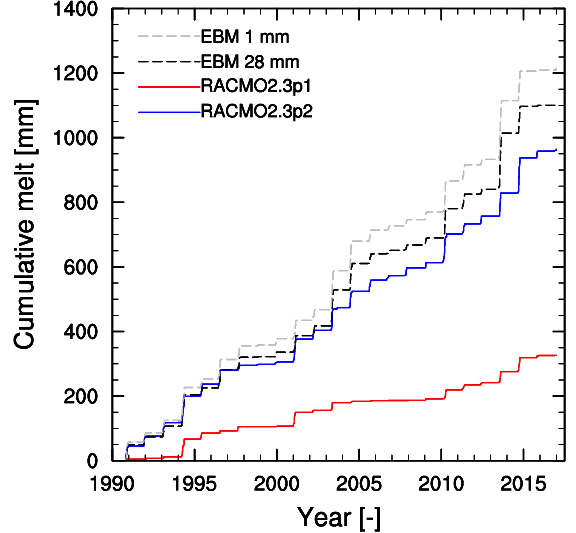
Figure 12. Cumulative melt at Neumayer calculated by the energy balance model (EBM) for 1990–2015 with roughness length z 0 = 28mm (dashed black line), z 0 = 1mm (dashed grey line) and as modelled by RACMO2.3p2 (blue) and RACMO2.3p1 (red). Table 4. Total Antarctic Peninsula integrated SMB mean 1979– 2014 (the overlapping period for both model versions) values [Gty − 1 ] with interannual variability σ : total (snow and rain) precipitation ( P tot ), snowfall (SN), rainfall (RA), total sublima- tion (SU tot ), surface sublimation (SU s ), drifting snow sublima- tion (SU ds ), run-off (RU), snowmelt ( M ) and refrozen mass (RF). All values calculated on the RACMO2.3p2/AP ice mask without Larsen B. RACMO2.3p2 RACMO2.3p1 p2–p1